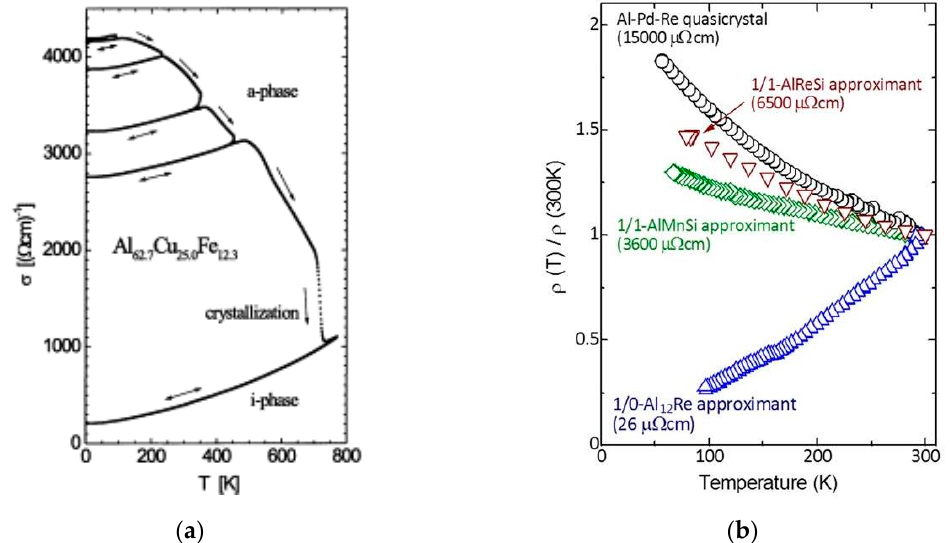
Figure 6. ( a ) Temperature dependence of the electrical conductivity of an AlCuFe thin film for different annealing states for the amorphous and for the i-QC phase. The conductivity progressively decreases when the long-range order quality is improved (spanning over more than one order of magnitude at low temperatures) and a clear inverse Matthiessen rule is observed in the σ (T) curves. (Reprinted from Haberken, R.; Khedhri, K.; Madel, C.; Häussler, P. Electronic transport properties of quasicrystalline thin films. Mater. Sci. Eng. A 2000 , 294-296 , 475-480. Copyright (2000), with permission from Elsevier); ( b ) temperature dependence of the electrical resistivity of a i-AlPdRe QC along with 1/1-AlReSi, 1/1-AlMnSi, and 1/0-Al 12 Re approximants. The low-temperature electrical resistivity values are indicated in the graph. (Reprinted from Takagiwa, Y.; Kirihara, K. Metallic-covalent bonding conversion and thermoelectric properties of Al-based icosahedral quasicrystals and approximants. Sci. Technol. Adv. Mater. 2014 , 15, 044802; doi:10.1088/1468-6996/15/4/044802, Creative Commons Atribution-NonCommercial-ShareAlike 3.0 License).